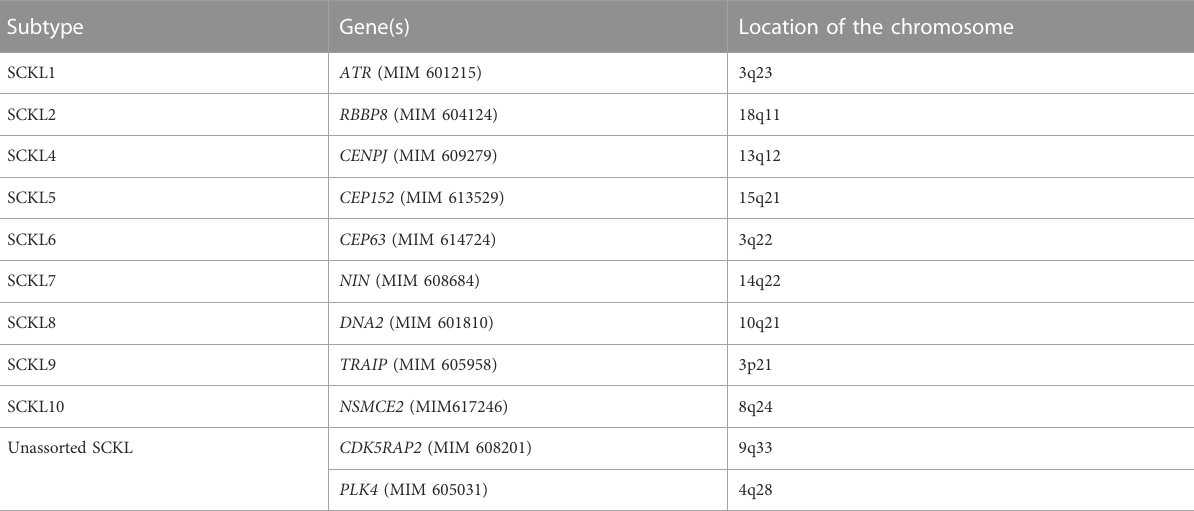
TABLE 2 Correlation between genes and subtypes of